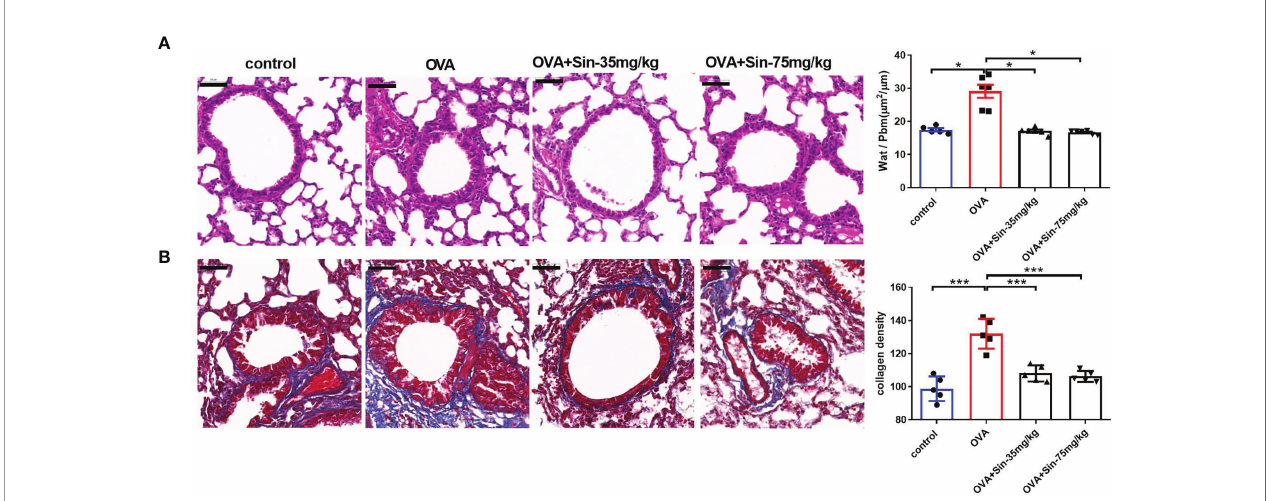
FIGURE 4 | Sin relieved airway remodeling and reduced collagen deposition in the lungs of mice with OVA-induced asthma. Scale bar indicates 50 m m. (A) Hematoxylin & eosin (H&E)-stained lung tissue specimen sections. The total area of the airway wall and the perimeter of the basement membrane (Wat/Pbm) were used to evaluate the airway remodeling. The Wat/Pbm values ( m m 2 / m m) are shown in Y-the axis. The non-parametric multiple comparison followed by Dunnett ’ s Multiple Comparison Test was used. (B) Masson staining was conducted on sections of the lung bronchi tissue, in which collagen fi bers are shown as blue. The subepithelial collagen density was quanti fi ed. The one-way analysis of variance followed by Dunnett ’ s Multiple Comparison Test was used. The data are presented as mean ± SEM (n=5-6/group). *p < 0.05. ***p <